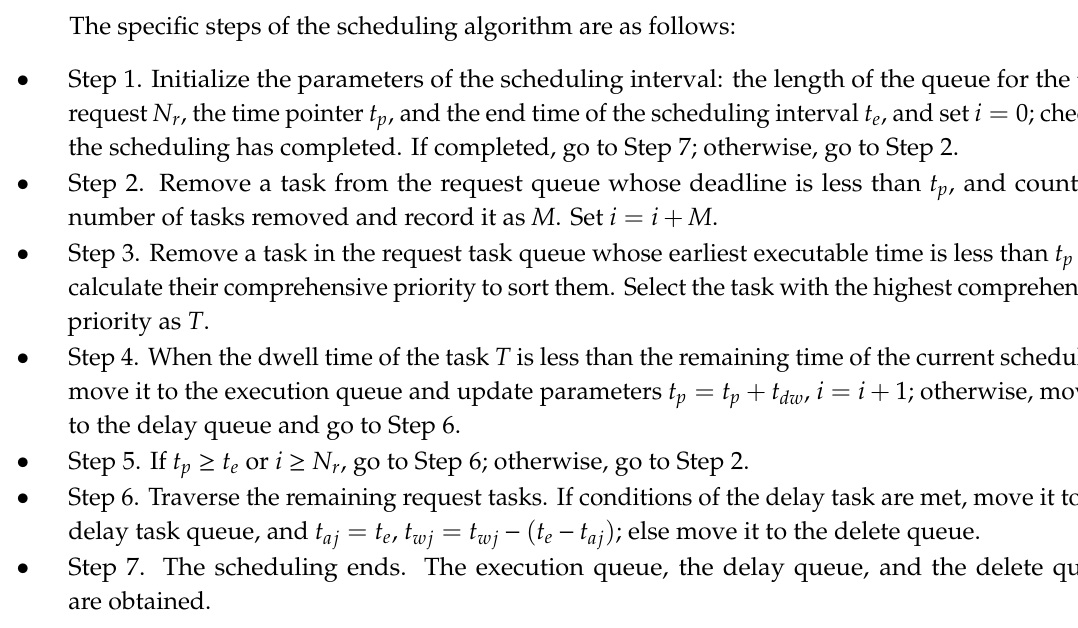
Figure 1. The flow chart of the proposed radar scheduling algorithm.